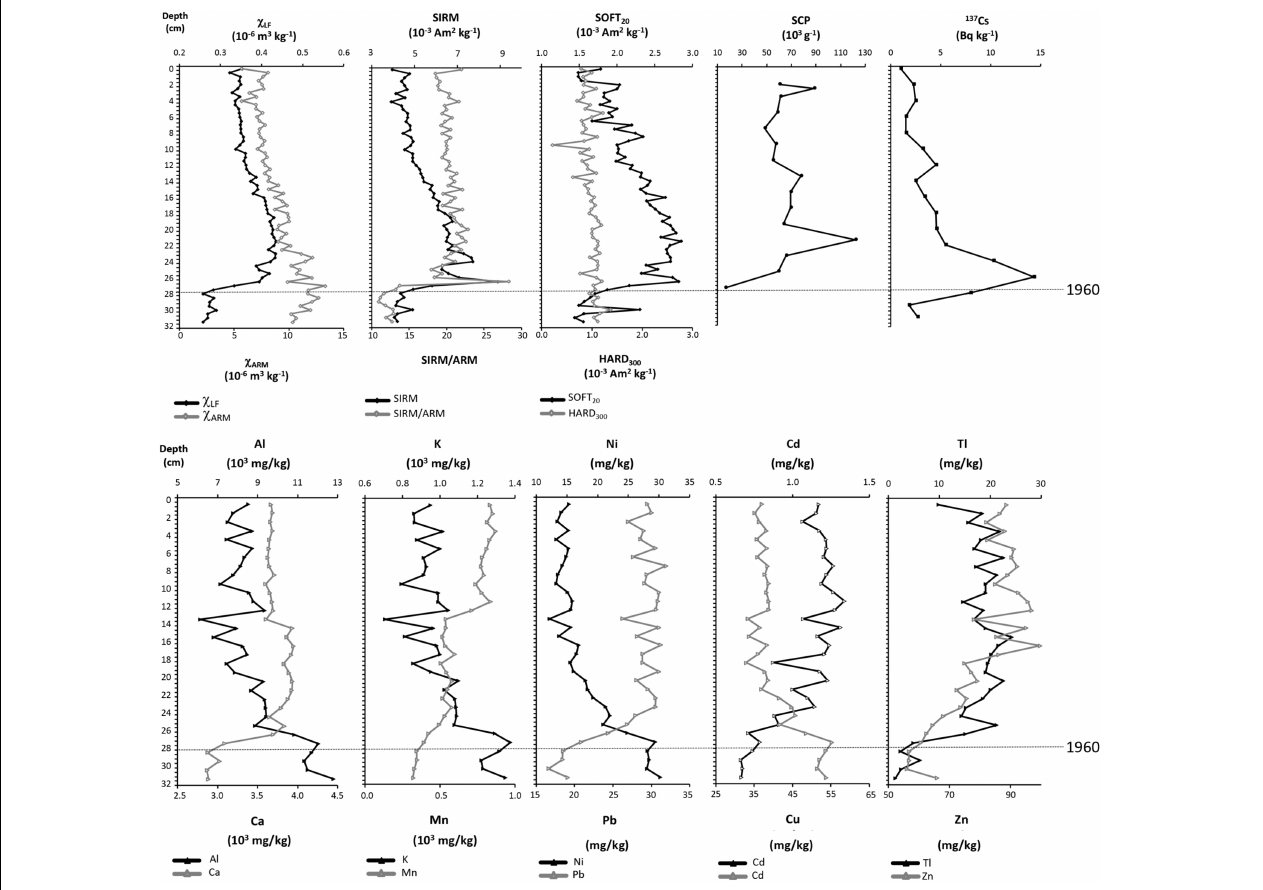
FIGURE 3 | Down-core concentrations of selected geomagnetic parameters, 137 Cs, elements and SCPs for Sky Pond (SKP1), showing the basal layer at ∼